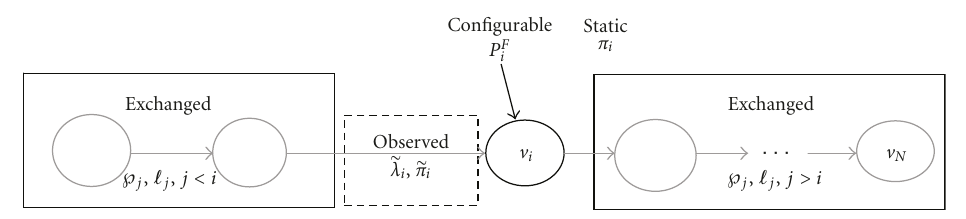
Figure 4: The various parameters in relation to v i